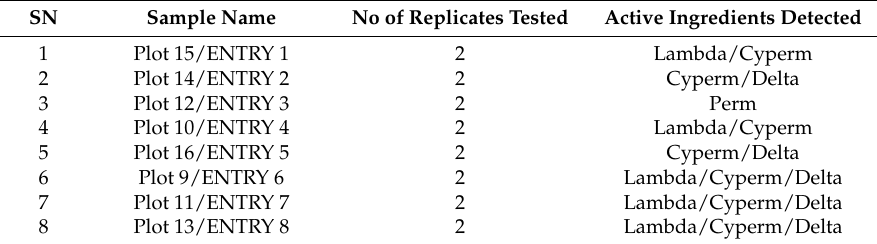
Table 2. The active ingredients that were detected in soils samples.